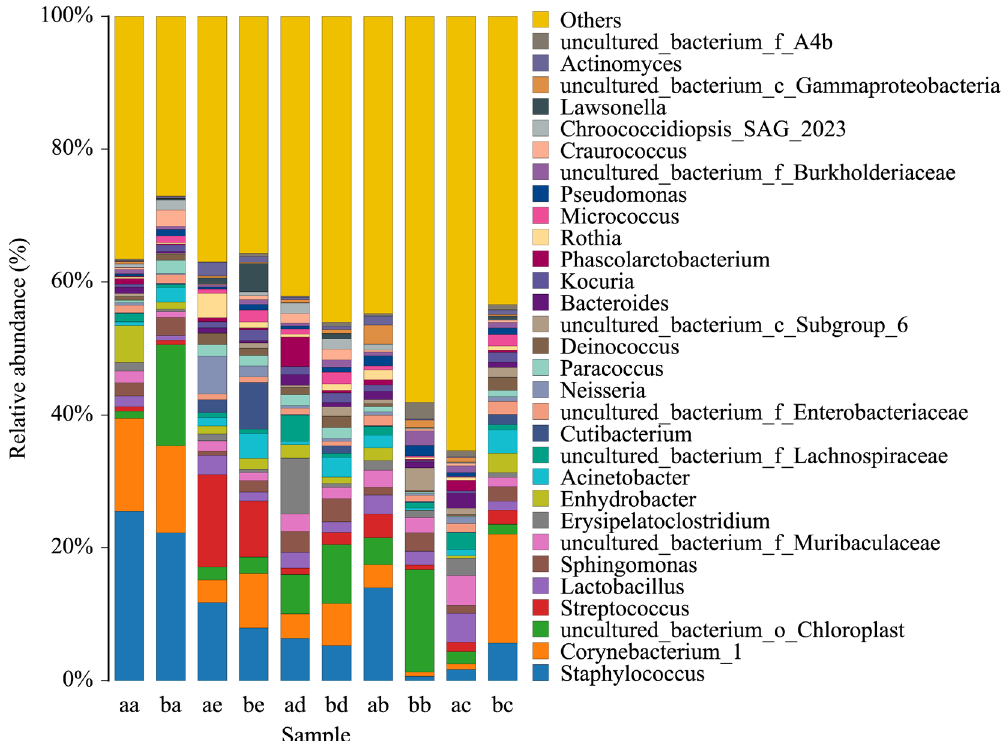
Figure 1. Bacterial composition and relative abundance of main apparatus in two gyms (Top 30). a/RG Gym: aa (carpet), ab (barre), ac (hoop), ad (ball), ae (palm). b/AG Gym: ba (carpet), bb (wall bars), bc (horizontal bar), bd (parallel bars), be (palm).